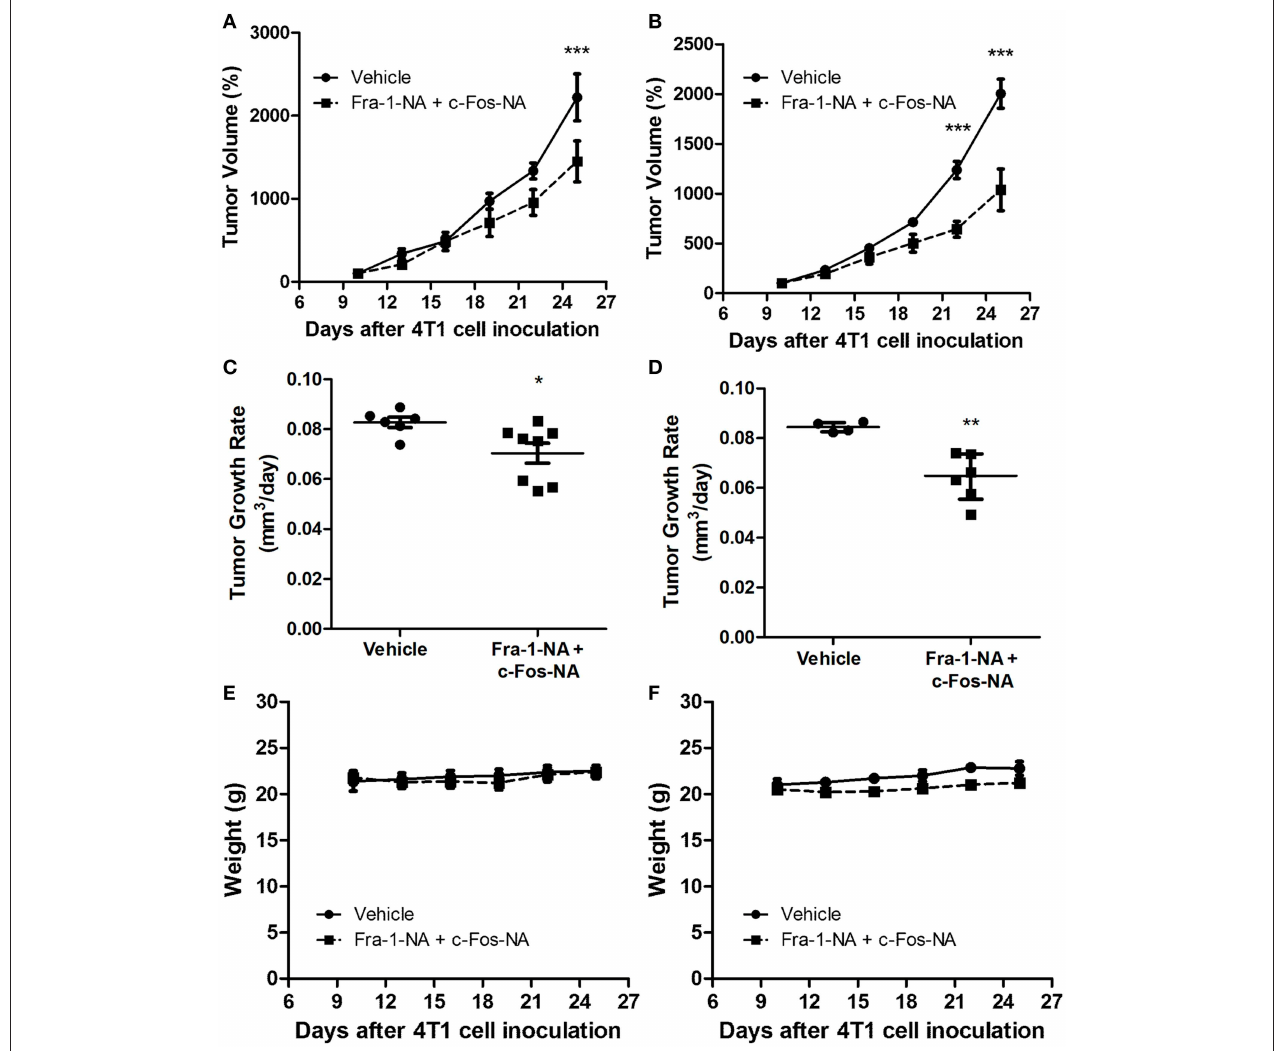
FIGURE 5 | Fra-1-NA plus c-Fos-NA inhibit breast tumor growth. Mice bearing one tumor received an intratumoral injection of liposomes containing Fra1-NA plus c-Fos-NA. Peptide administered: 5 injections containing 4.5 nmol per injection (dashed line) or vehicle (continuous line) (A,C,E) or 9 nmol per injection (B,D,F) delivered three times a week for 15 days. In (A,C,E) , control group: n = 6; treated group: n = 8; in (B,D,F) , control group: n = 4; treated group: n = 6. (A,B) Tumor volumes were measured at 3-day intervals during the treatment period. Results are expressed as the percent volume taking the volume of the tumor at 10 days of inoculation as 100%. *** p < 0.001 (Two-way ANOVA, Bonferroni post-test). (C,D) Tumor growth rates were calculated for each group at the end of the treatment as the slope of the curve obtained by plotting the log 10 of the tumor volume in function of the days of treatment. Horizontal bars represent mean (C) or median (D) values according to the distribution of the data (parametric and non-parametric ANOVA, respectively) * p < 0.05; ** p < 0.01. (E,F) Body weight of animals during the treatment period. Fra-1 (dark gray bars in Figure 7C ) or c-Fos (dark gray bars in Figure 7D ) activated CDS but if in addition to the recombinant Fra-1 or c-Fos proteins, the N-terminus deletion mutants were included in the reaction, CDS activity decreased to similar levels of those obtained in the MF treated with KCl 1M of each condition (black bars in Figures 7C,D